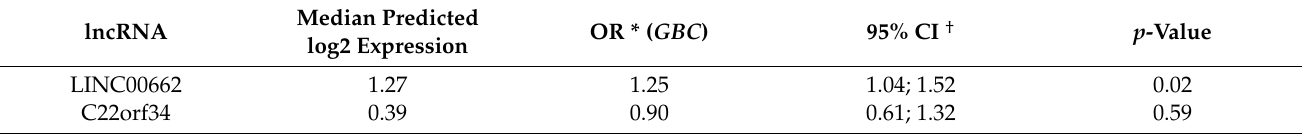
Table 3. Predicted genotype-based log2 expression of LINC00662 and C22orf34 and their association with GBC risk in the lncRNA- GBC association